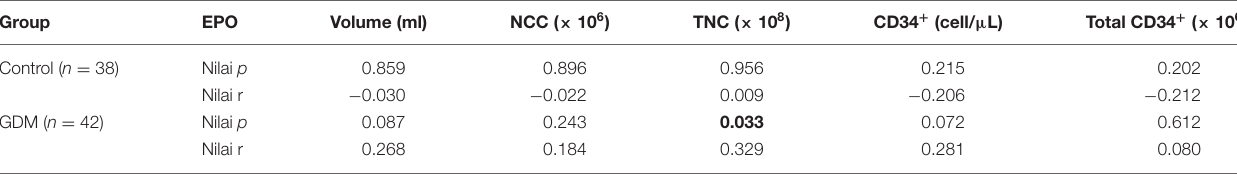
TABLE 3 | A correlation between UCB parameters and EPO level in GDM and Control groups. Group